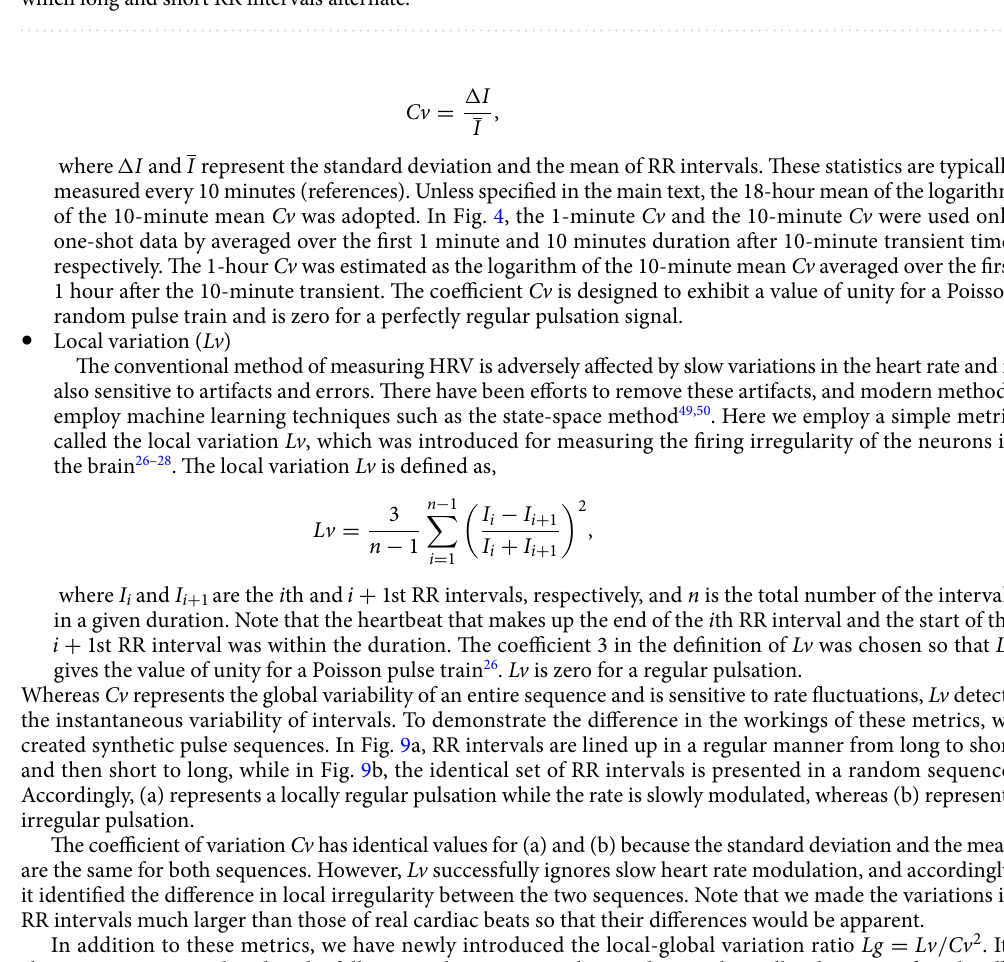
Figure 9. Synthetic pulse sequences and the computed values of the coefficient of variation Cv , the local variation Lv , and the local-global variation ratio Lg . ( a ) Pulsation is locally regular while the rate is slowly modulated from low to high and then back to low. ( b ) Pulsation is irregular, although the average rate is nearly constant. ( c ) Long and short RR intervals alternate with each other. Cv has the same value for ( a ) and ( b ), which are composed of identical sets of RR intervals, whereas Lv is small for ( a ), in which the RR intervals are well organized, and is large for ( b ), in which RR intervals are arranged randomly. Lg is very small for ( a ), in which 3 / 2 for ( b ), in which RR intervals are randomly arranged. Lg 3 for ( c ), in the rate is slowly modulated. Lg ≈ ≈ which long and short RR intervals